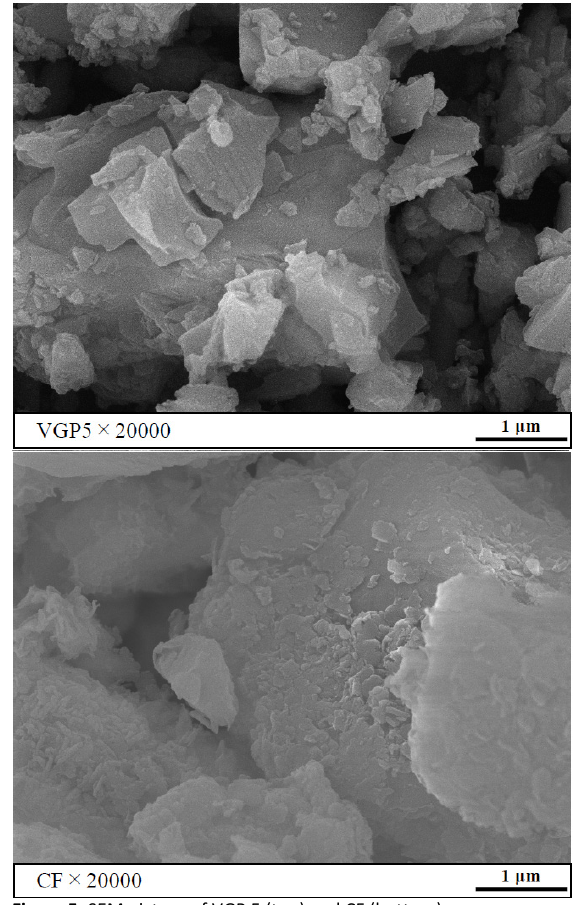
Figure 5. SEM picture of VGP 5 (top) and CF (bottom). Table 3 and Fig. 6 show the XRD patterns and results of mineral phase quantification, respectively. The amorphous content of VGP 5 with a density of 2.4 g/cm 3 or less is 98.7%, demonstrating that it is high purity volcanic glass. On the other hand, the amorphous content of VGP 5 with a density of more than 2.4 g/cm 3 is 73%, but crystalline minerals such as quartz are also contained. The amorphous content of the antigorite, are contained. The density of individual volcanic particles may vary; but it was reported that the ones of shards commonly have densities of 2.35 to 2.45 g/m 3 , lithic fragments range from 2.7 to 3.2 g/m 3 , and crystals vary from about 2.6 to 5.2 g/m 3 [6]. These results demonstrate that sorting out particles less than 2.4 g/cm 3 by dry gravity concentration and removal of smaller clay fraction by bag filter is technically